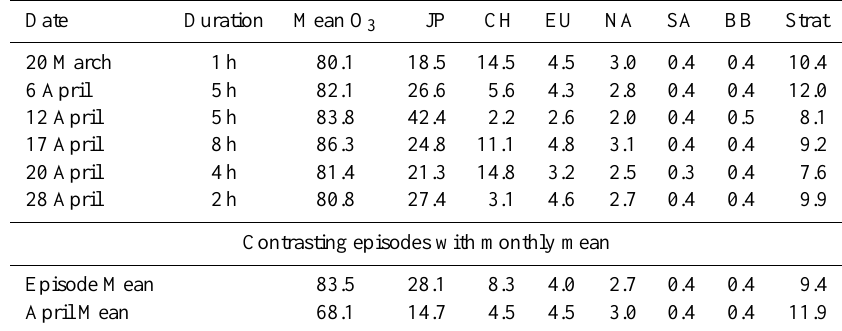
Table 6. Source Contributions to Surface O 3 (ppb) in Tokyo During High O 3 Episodes (O 3 > 80ppb) in Spring